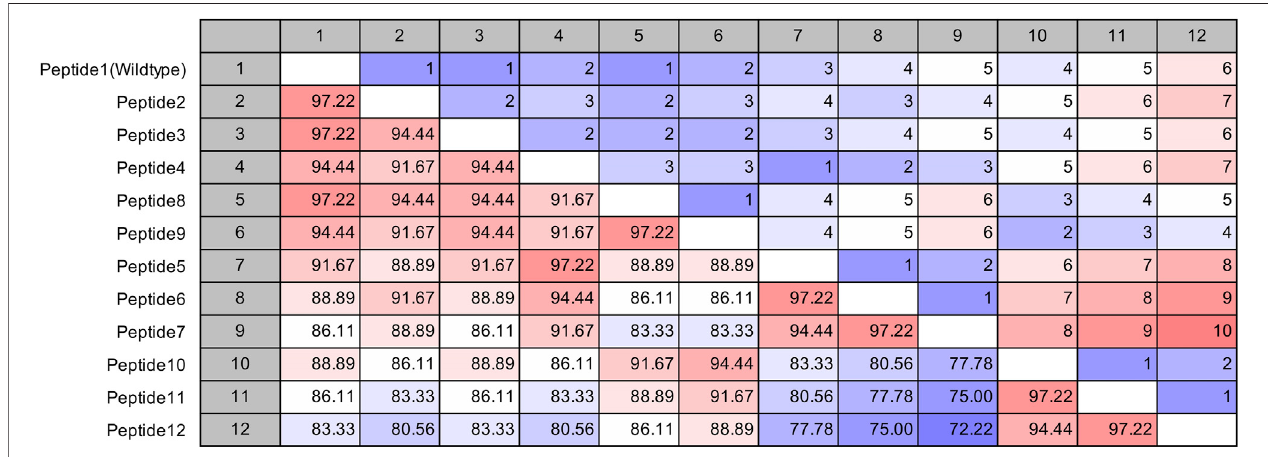
FIGURE 2 | Pairwise comparison of the synthesized MERS-CoV inhibitor peptides. The upper diagonal panel shows the number of amino acid differences. The lower diagonal panel shows the identity. The color scale indicates extreme values.